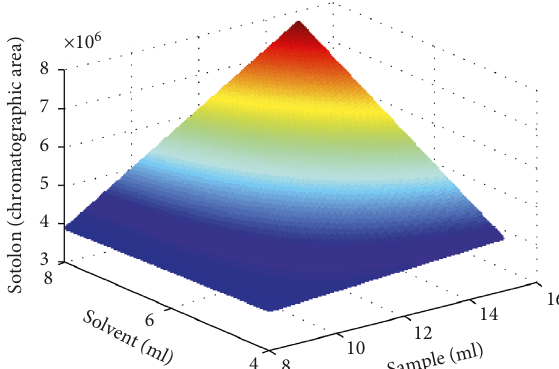
Figure 1: Results obtained using the design of experiment to optimize the single-step extraction procedure, with sample and solvent extraction volumes as variables. The colormap illustrates the variation of the LC-MS/MS response of sotolon.